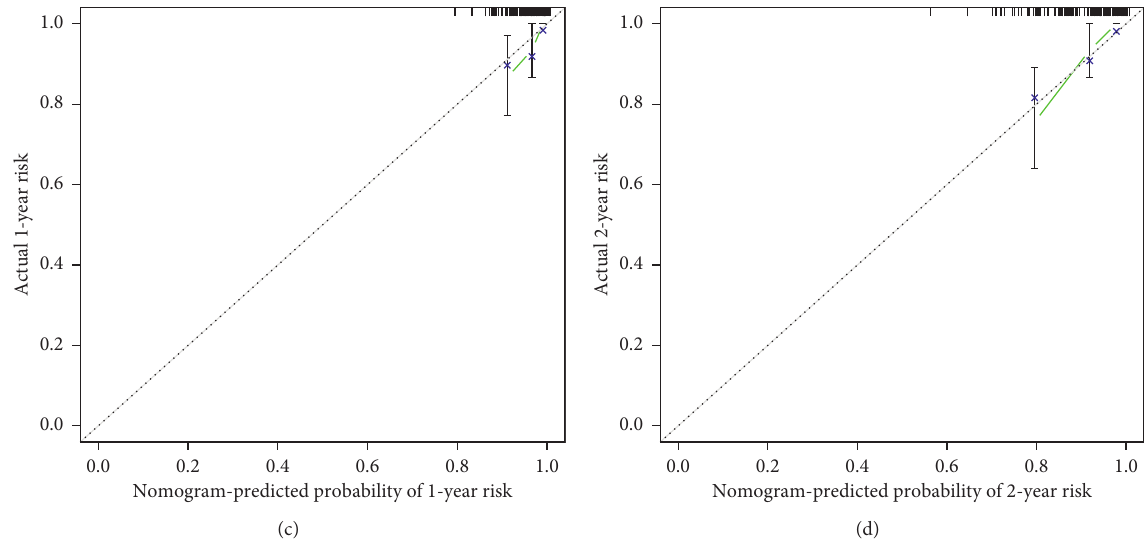
Figure 3: The calibration curve for predicting major adverse cardiovascular events probability at (a) 1 year and (b) 2 years in the evaluation cohort and at (c) 1 year and (d) 2 years in the validation cohort. Nomogram-predicted probability of major adverse cardiovascular events is plotted on the X -axis; actual probability is plotted on the Y